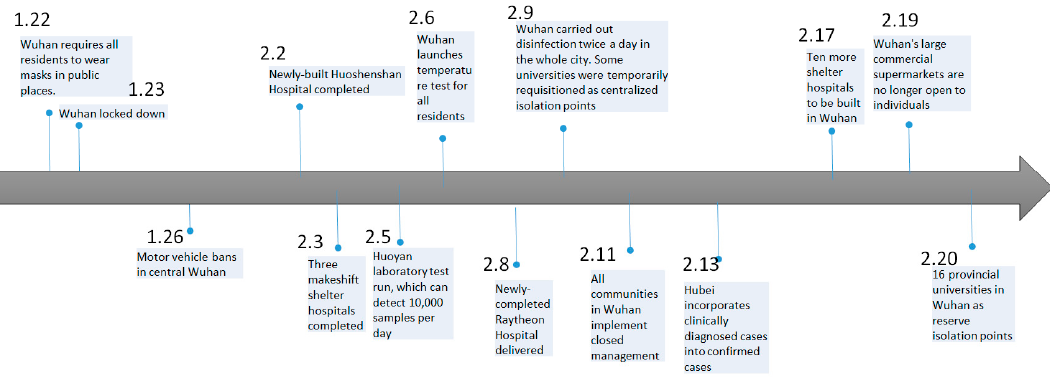
Figure 4. Chronology of China’s response to COVID-19 .